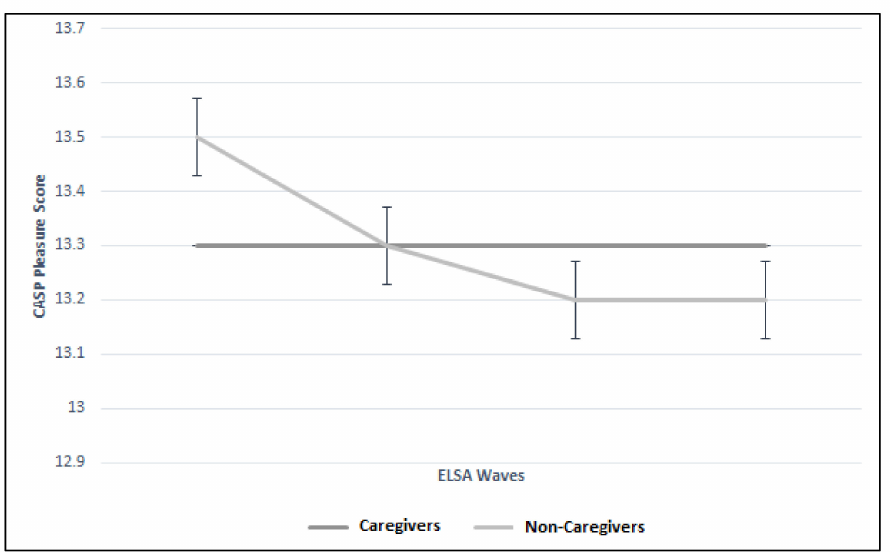
Figure 6. Trajectory of pleasure CASP score between caregiver and non-caregiver cohorts across four ELSA waves.